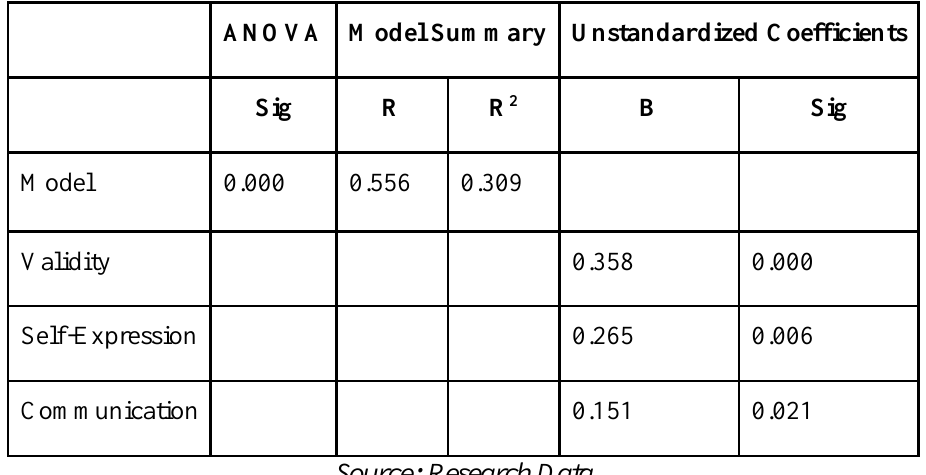
Table 1: Summary of Regression